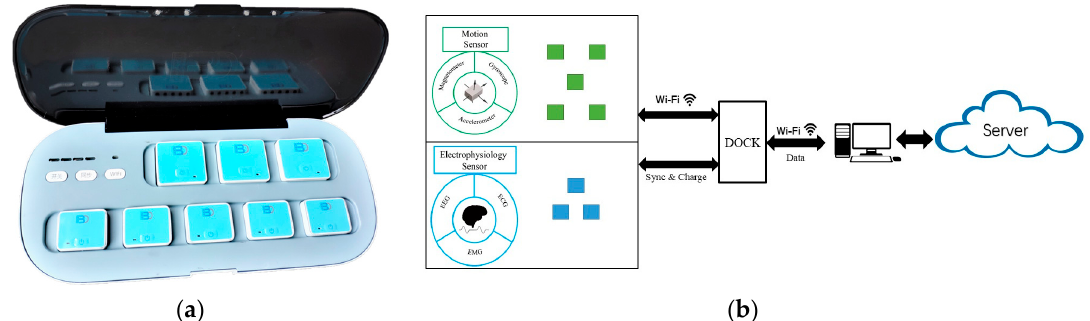
Figure 1. ( a ) The hardware including the sensors and dock. ( b ) Overview of the system diagram.